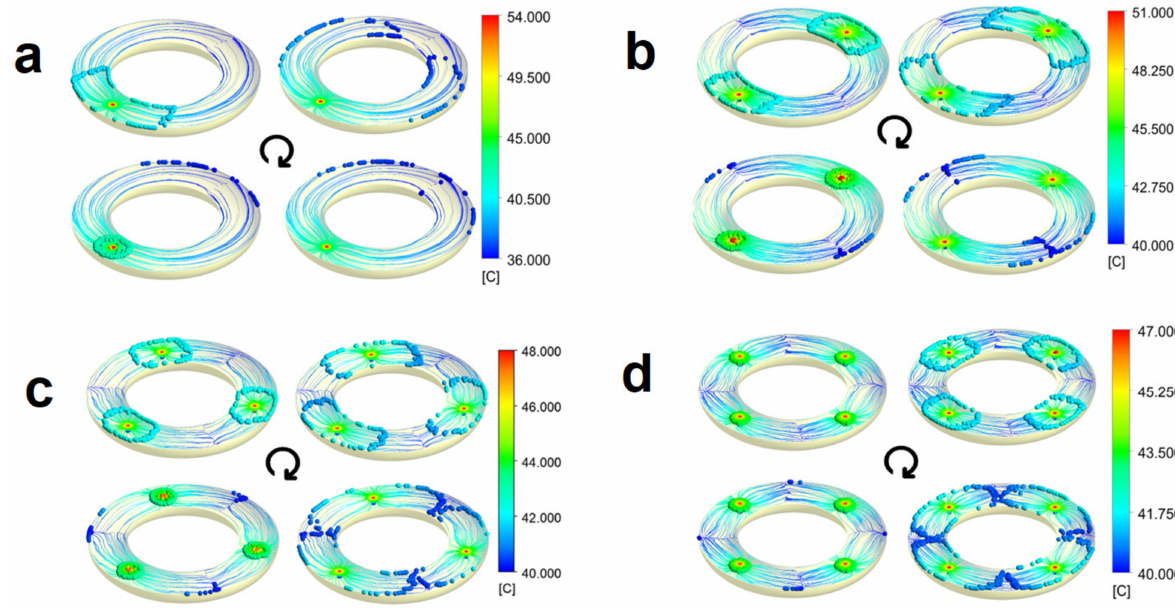
Figure 12. Streamlines with markers emanating from volumetric heat sources at 3600 s for multiple heat sources: ( a ) case F, ( b ) case G, ( c ) case H and ( d ) case I. Each case has four sub-figures in a clockwise direction illustrating the makers travelling along the lines.